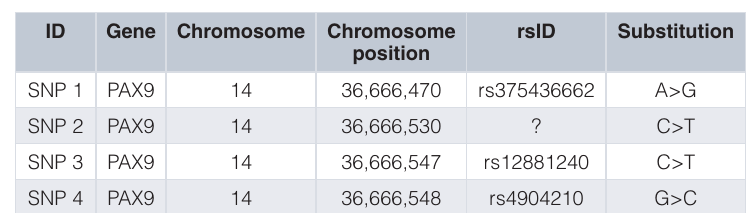
Table 3. SNP annotations.